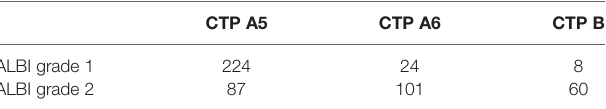
TABLE 2 | Correspondences between the CTP scores and ALBI grades in the entire cohort (n = 504).